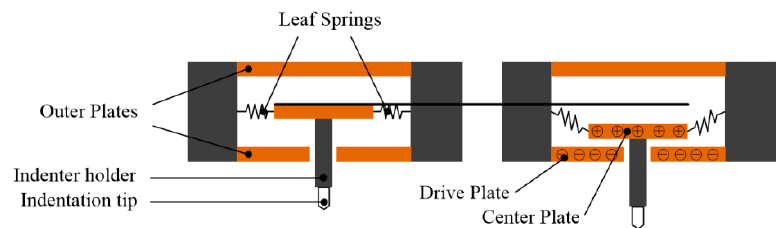
Figure 3. Schematic diagram of electrostatic driving method.